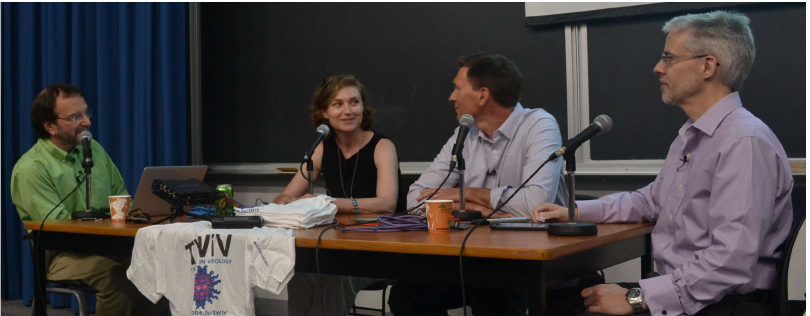
Figure 3. Live-taping of the 499th episode of the This Week in Virology (TWiV) podcast. TWiV was hosted by Dr. Vincent Racaniello (Columbia University, seated far left) and science writer Dr. Alan Dove (seated, far right). Here, Drs. Nathalie Grandvaux and Craig McCormick discuss the Canadian virology community, the origins of CSV, and ideas about the next steps for the society. TWiV 499 also featured interviews with Dr. Ryan Noyce (University of Alberta) and Dr. Kate O’Brien (Johns Hopkins University).